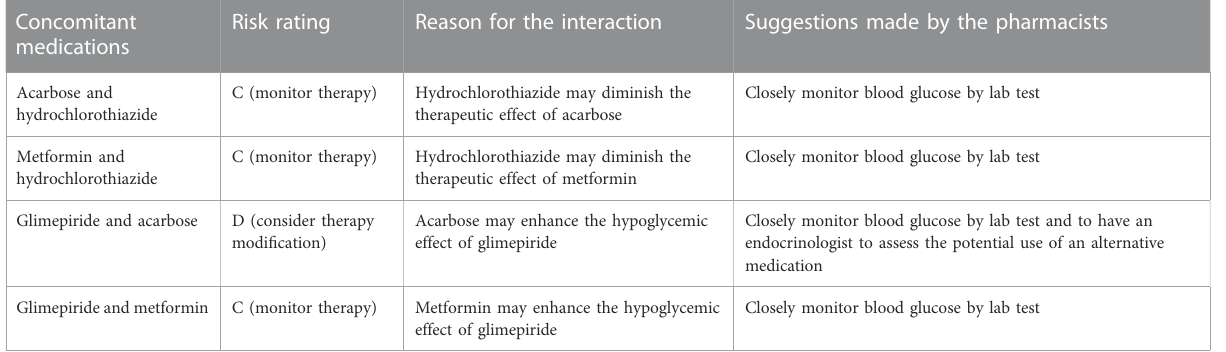
Table 2. There were 27.71% of the patients who had dose adjustments due to ADRs. In addition, we also compared the ADR pro fi les among different groups of patients, and the result showed that the tolerability in patients treated with olaparib for “ fi rst-line maintenance ” was not different with those for “ recurrence maintenance ” (Table 3).